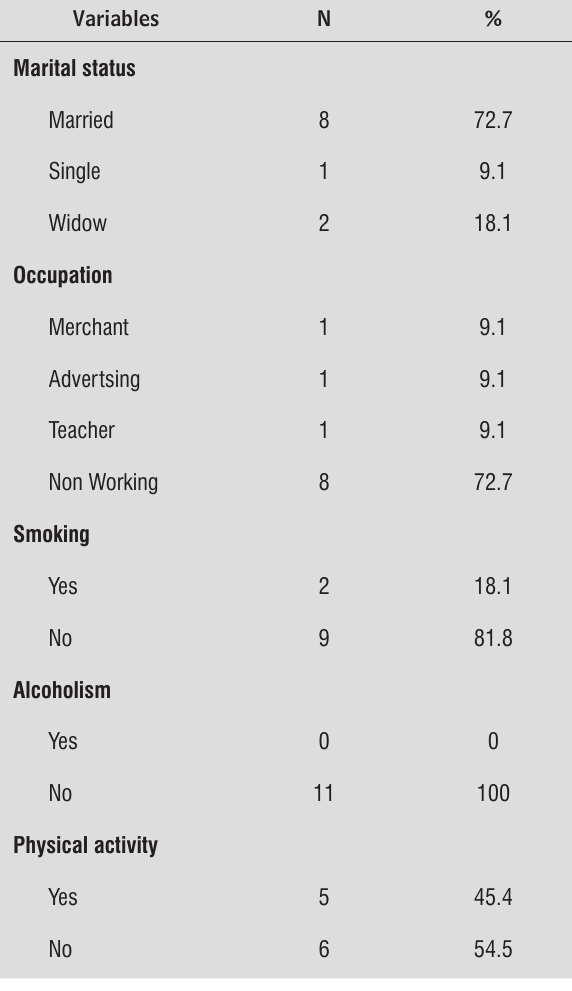
Table 1 - Characteristics of individuals with sleep disor- ders, Maringá-PR.